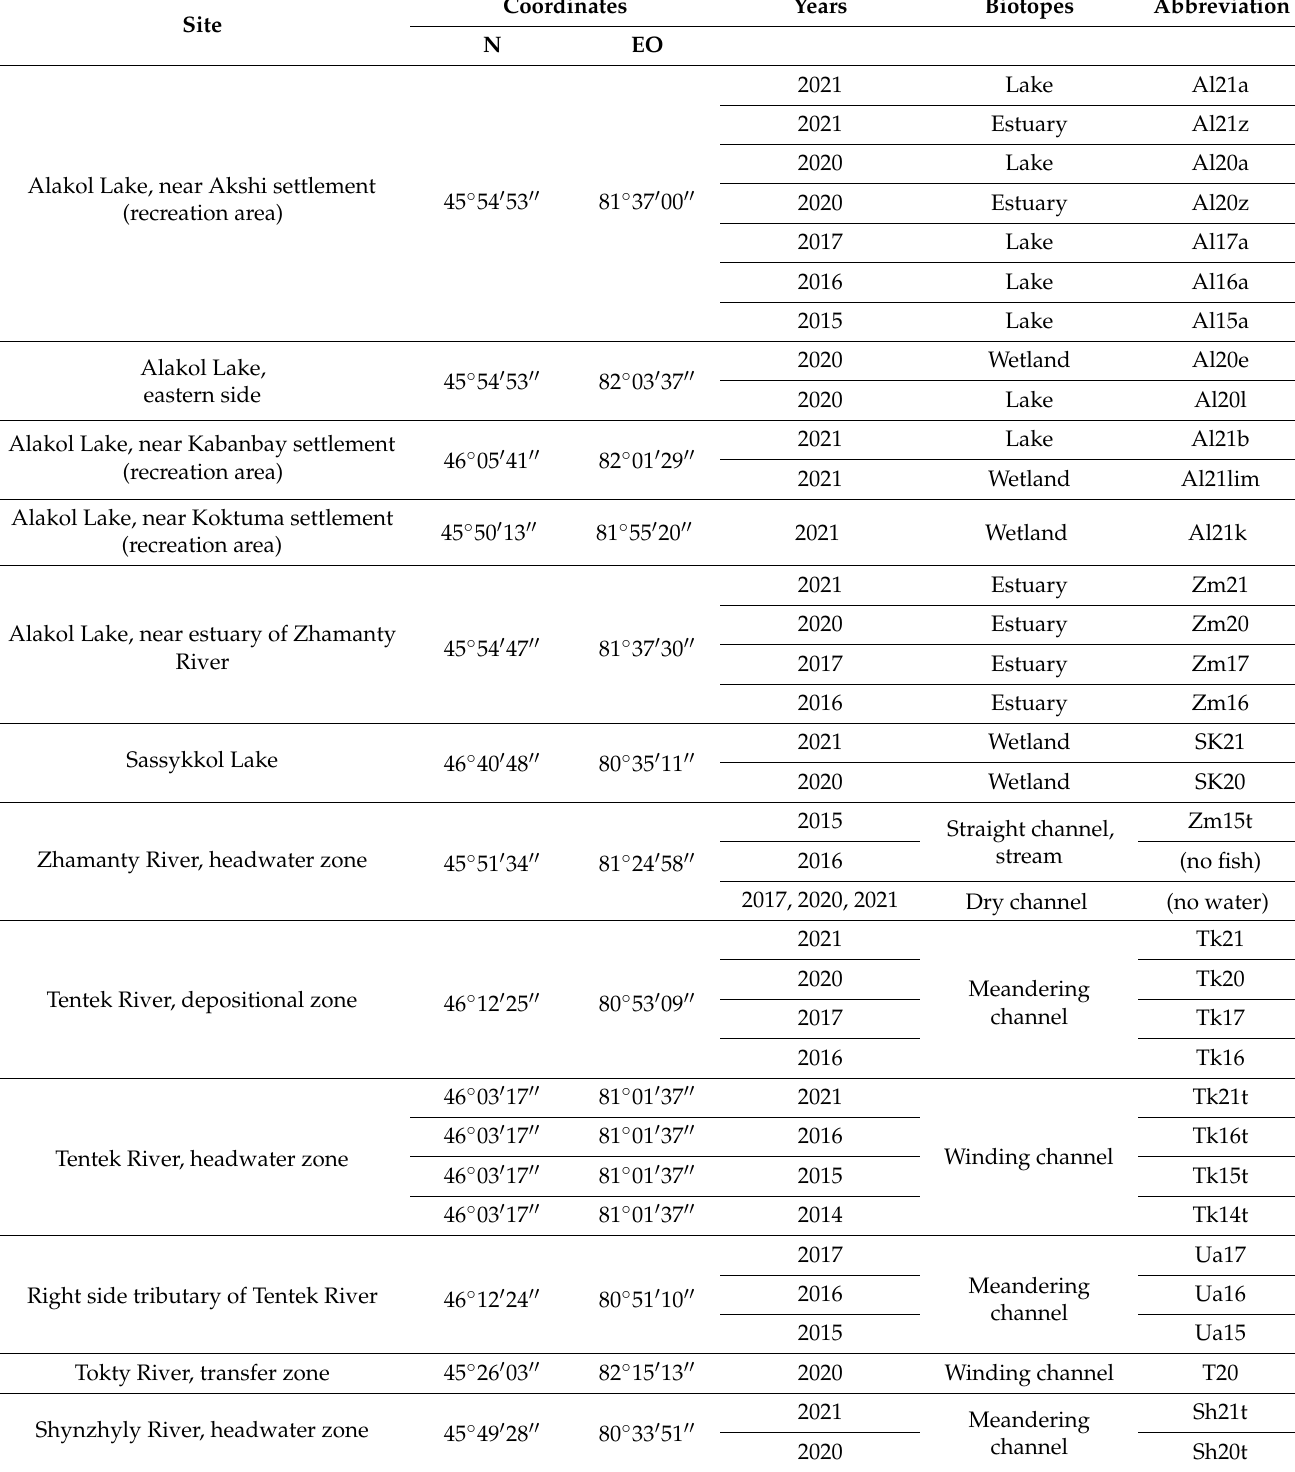
Table 2. Coordinates and abbreviations of sampling